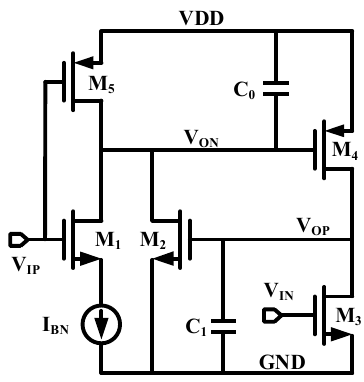
Figure 1. Complementary metal–oxide–semiconductor (CMOS) thyrsitor based delay cell.